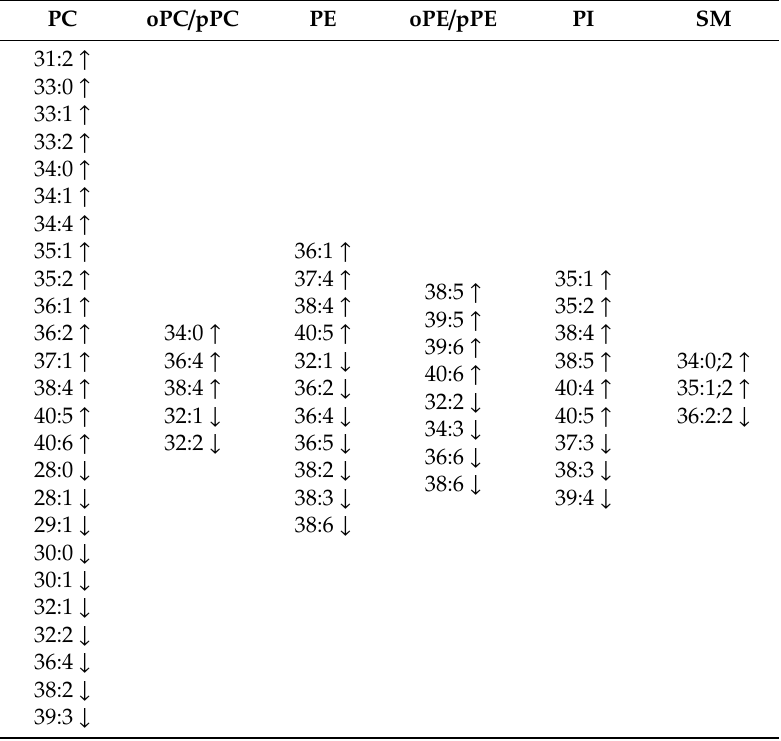
Table 3. Summary of lipids down- or up-regulated (compared to a control) in a PD patient rated as 5 on the Hoehn and Yahr